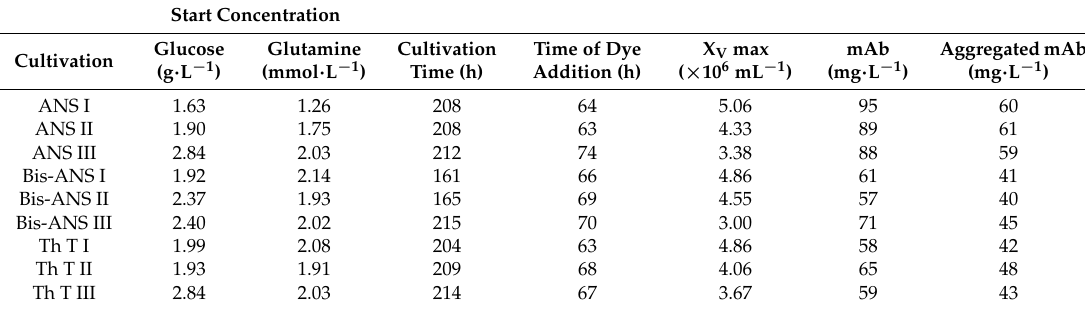
Table 1. Culture conditions for all fed-batch fermentations expressing a full-size monoclonal antibody in the presence of extrinsic dyes. ANS: 1-anilinonaphthalene-8-sulfonate; Bis-ANS: 4,4 (cid:48) -bis-1-anilinonaphthalene-8-sulfonate; mAb: monoclonal antibody; Th T: thioflavin